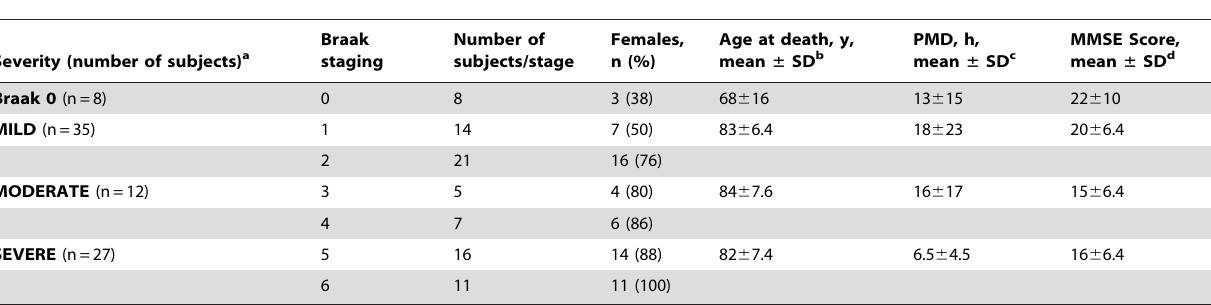
Table 2. Demographic and clinical characteristics of the AD patients and Braak 0